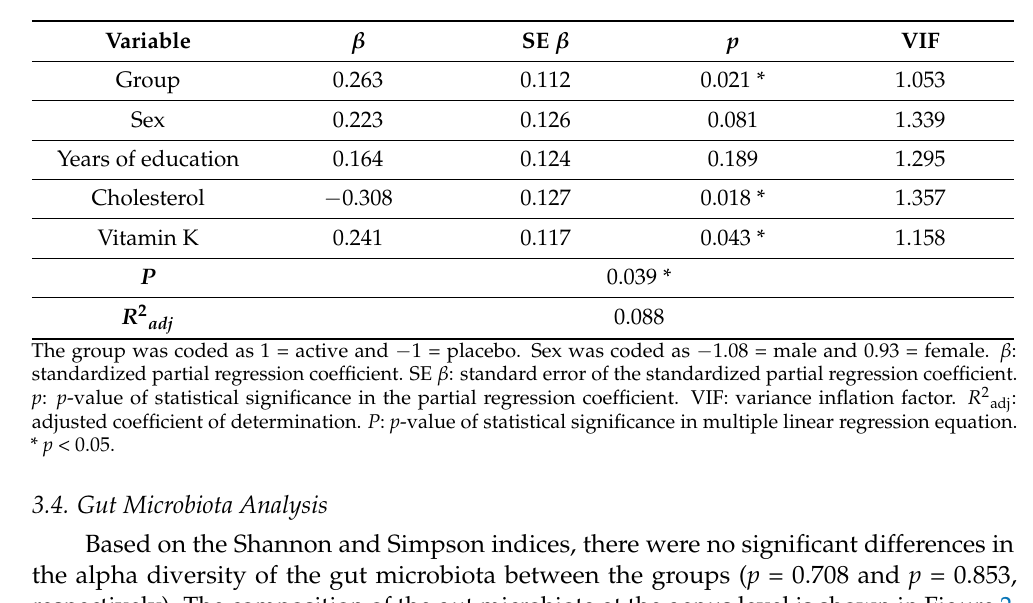
Table 5. Multiple regression analysis of the change in composite memory score and the intake of cholesterol and vitamin K.